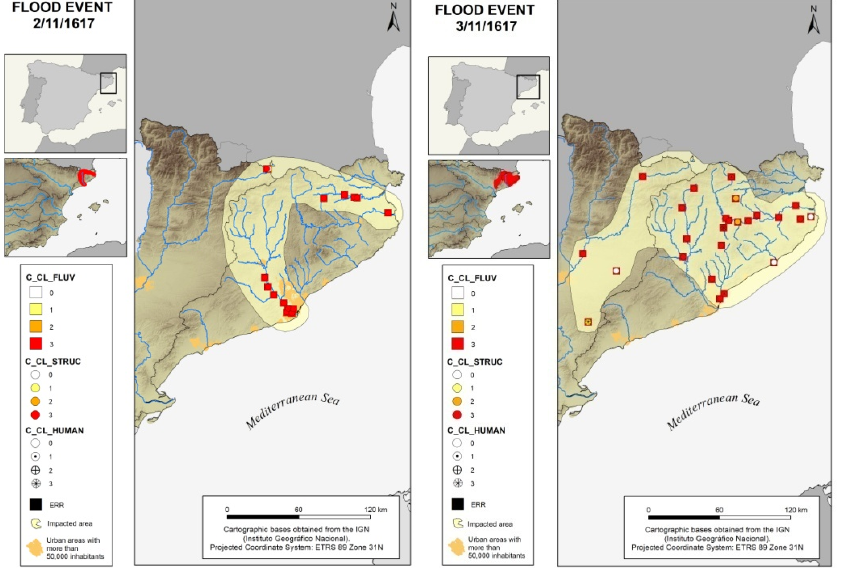
Figure 2. ( Left ): Representation of cases for the flood event of 2 November 1617. ( Right ): Repre- sentation of cases for the flood event of 3 November 1617. C_CL_FLUV: Variable 1. Hydraulic be- haviour of the river flood. C_CL_STRUC: Variable 2. Flood impact on structural elements. C_CL_HUMAN: Variable 3. Social/personal vulnerability to the flood. ERR: Erroneous or spurious cases. Blue line: Basic fluvial system. Black line: Spanish Hydrographic Demarcations. Urban areas: Population according to 2022 demographic record.